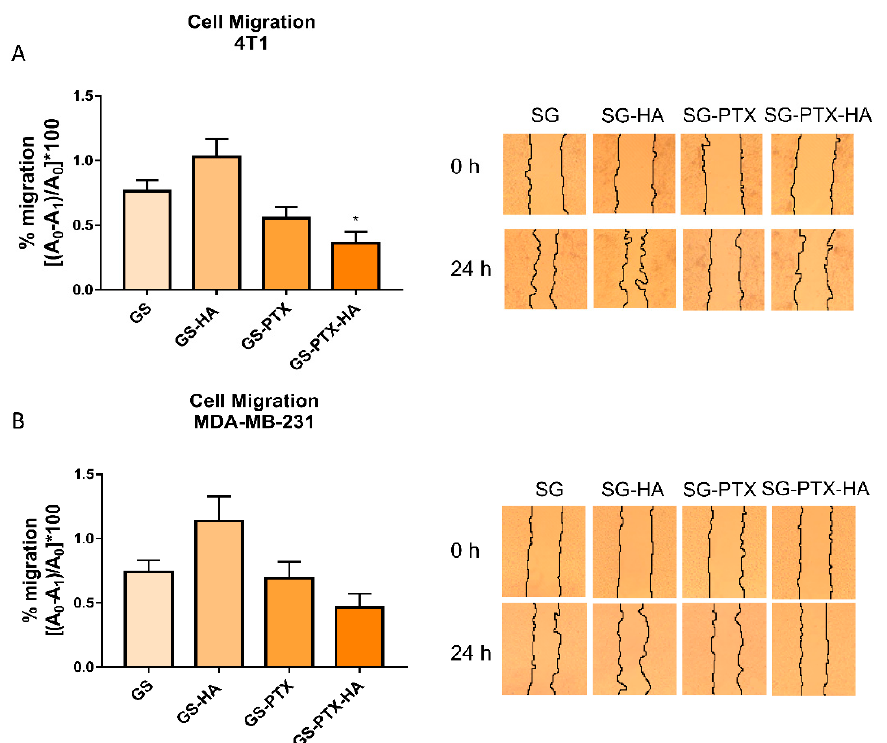
Figure 4. Modulation of cell migration in ( A ) 4T1 and ( B ) MDA-MB-231 cells by nanomicellar formulations. Cells were treated with micellar systems (PTX 0.01 µg/mL). The percentage of cell migration calculated [(A0 − A1)/A0] * 100 as with respect to control is shown. A0 is the initial area and A1 is the area after 24 h of incubation. Error bars represent the mean ± SEM ( n = 3 independent experiments) (ANOVA and Tukey’s multiple comparisons test, * p < 0.05). Representative pictures are shown.